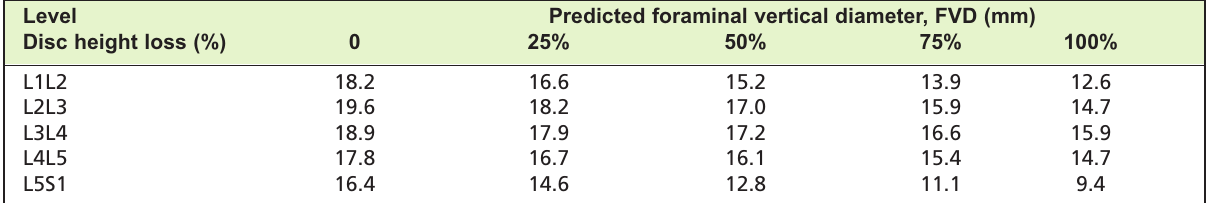
Predicted area available for the nerve root at the lateral foramen of the lumbar spine with percentages of disc Table III: